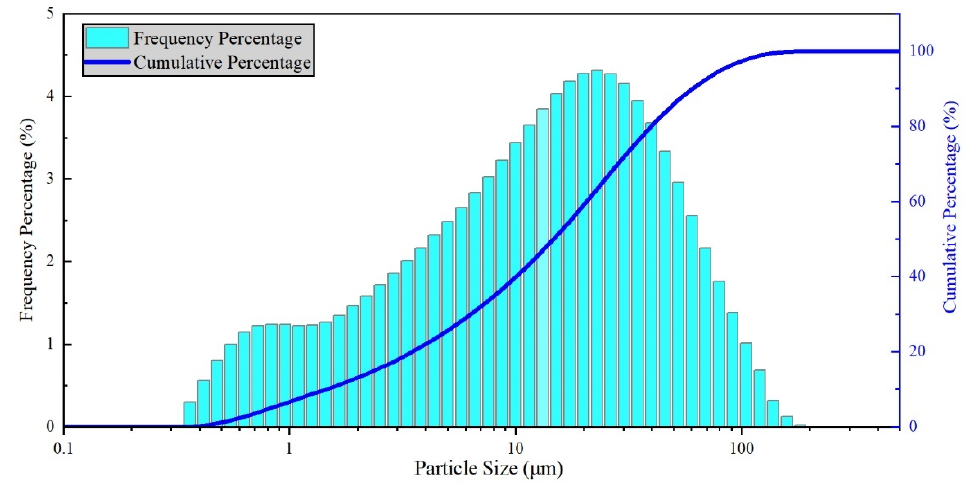
Figure 5. Particle size distribution curve of phosphorus tailing powder.